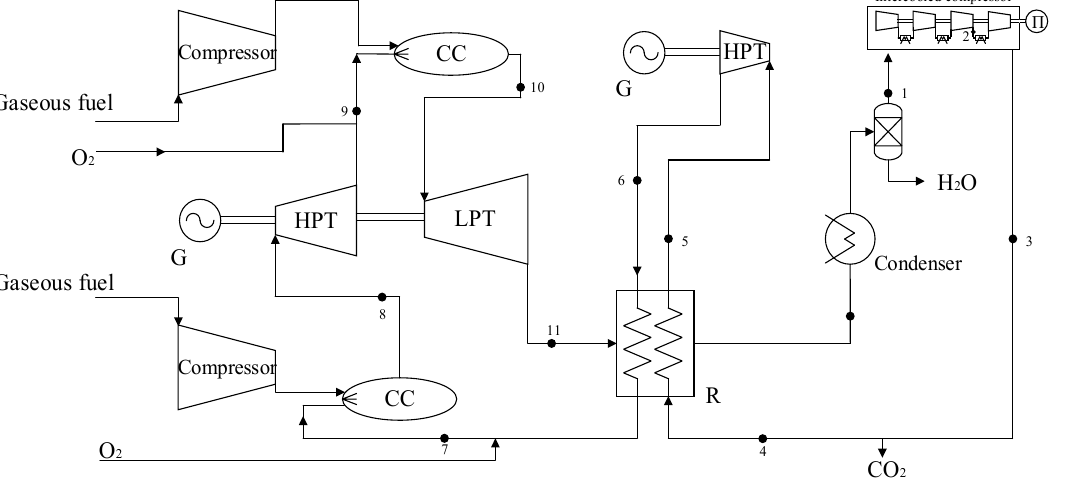
Figure 8. MATIANT cycle flow diagram.